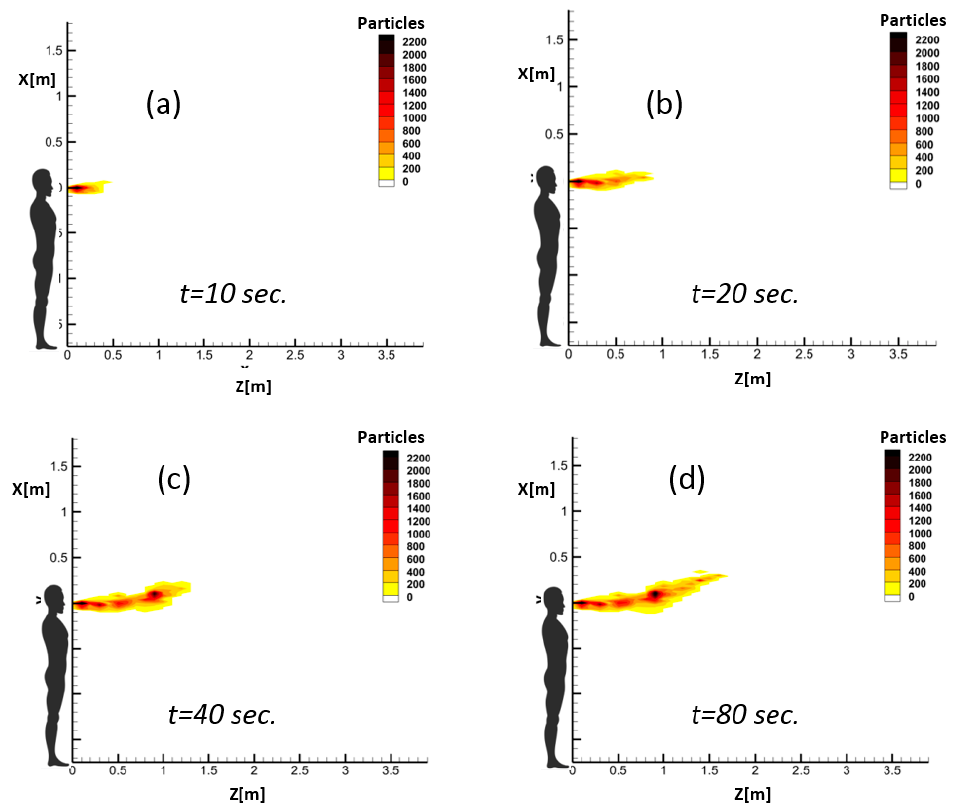
Figure 11. Time evolution of safe social distance for exhalation event of Case 4 (velocity = 22 m · s − 1 , temperature = 11 °C, RH = 19%).